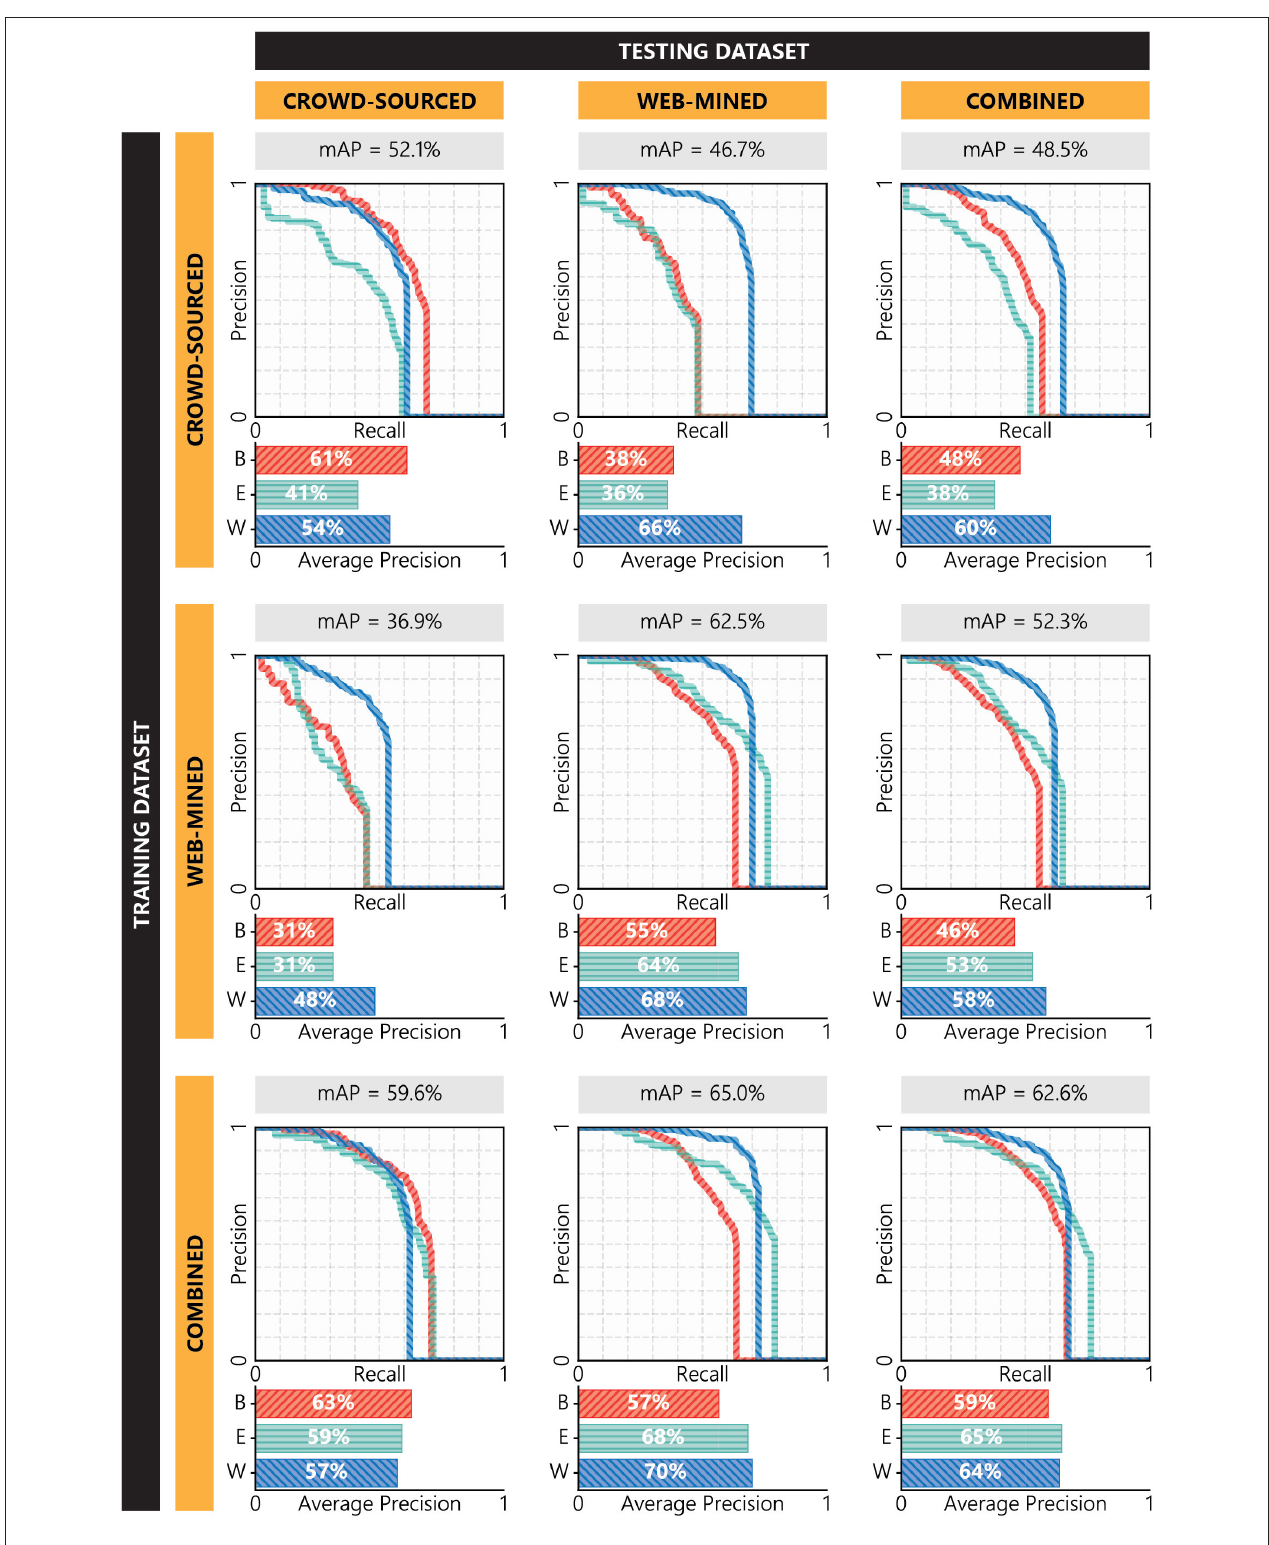
FIGURE 9 | Performance of YOLO-v2 models trained and tested on different combinations of the Pictor-v2 dataset.